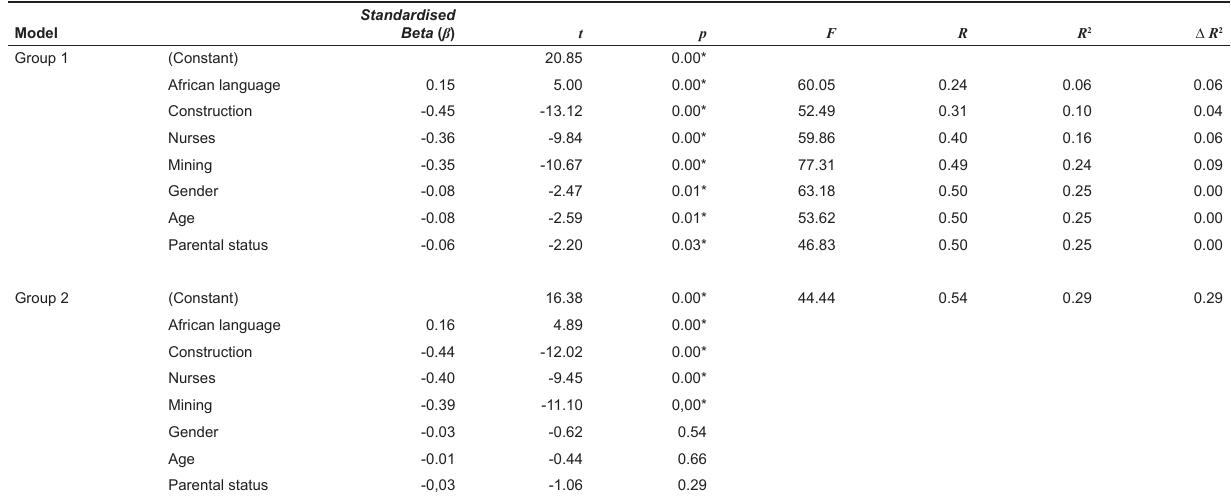
TABLE 4 Multiple regression analysis with negative HWI as dependent variable